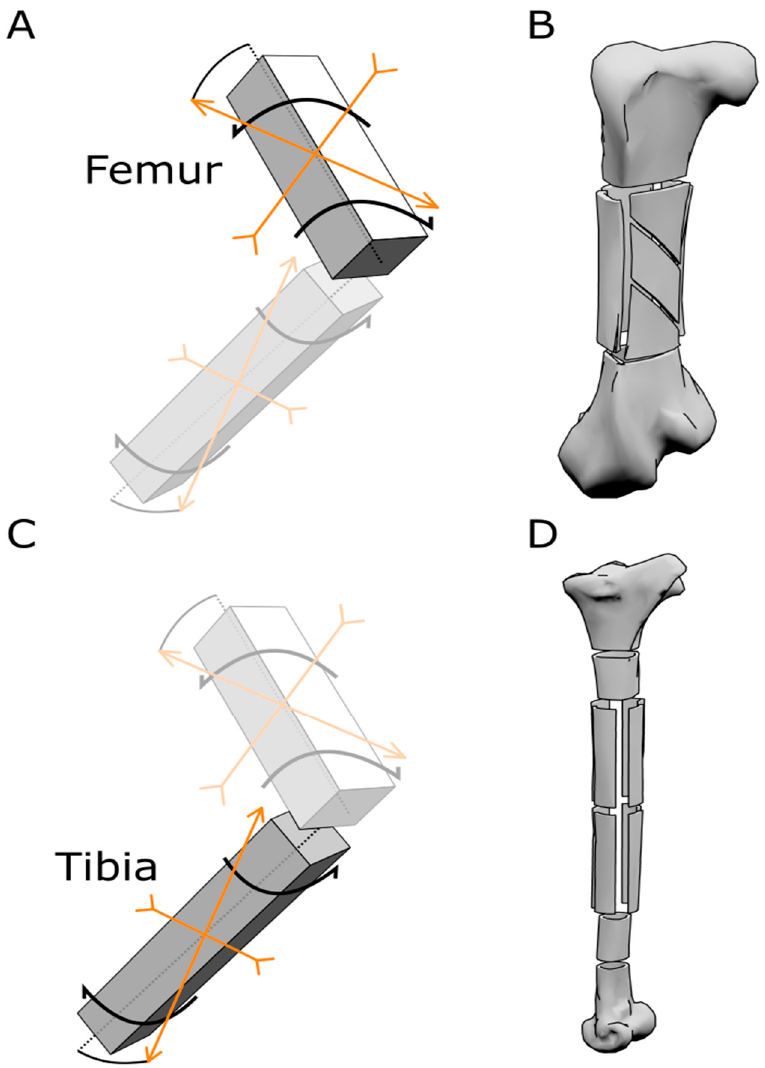
Figure 4. Scheme of force distribution and samples obtained from the ostrich bones. ( A ) Schematic model representing the direction of forces acting on the femur. ( B ) Model of an ostrich femur representing how the samples for the mechanical tests were cut out of the bone. ( C ) Schematic model representing the direction of forces acting on the tibia. ( D ) Model of an ostrich tibia representing how the samples for the mechanical tests were obtained from the bone.